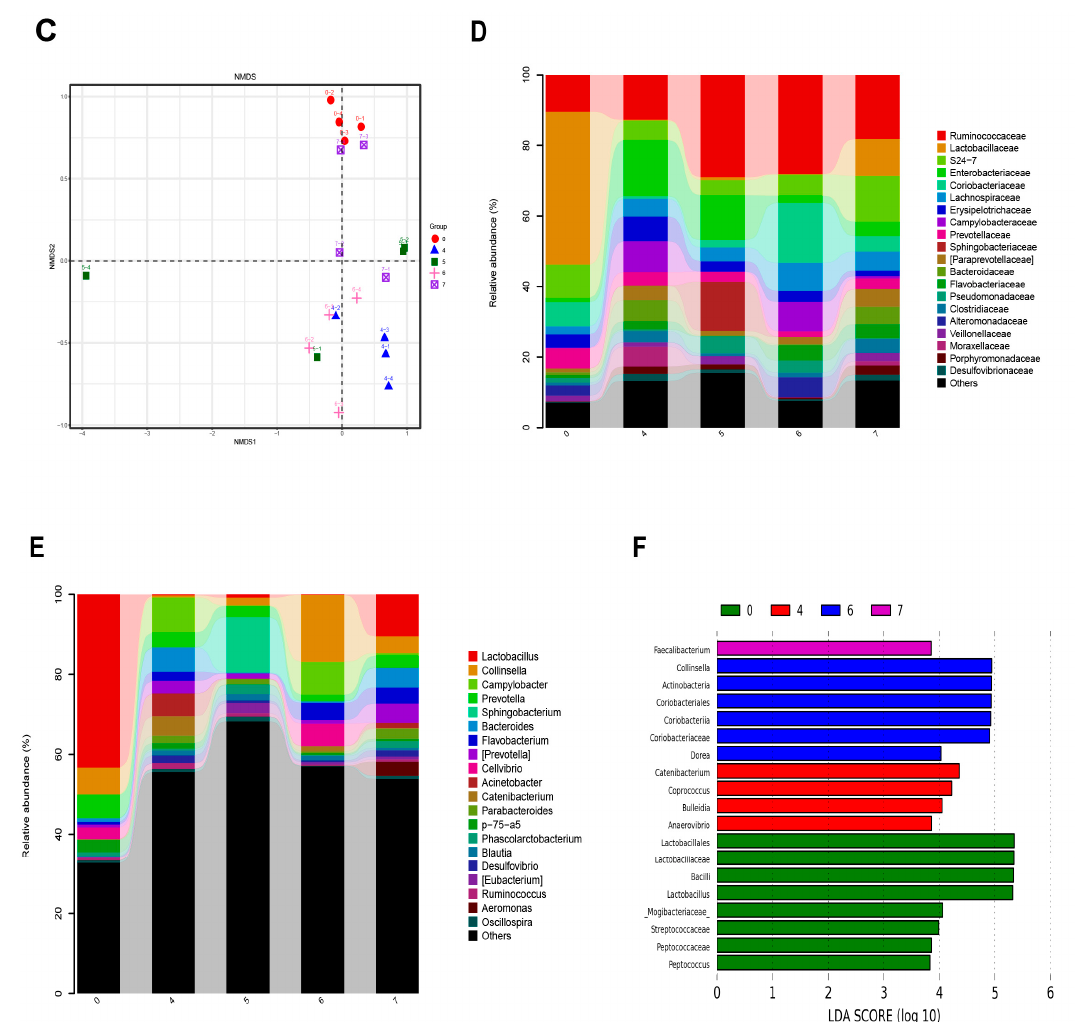
Figure 3. Effects of supplementing the diets with different combinations of SB, MCFAs, and omega − 3 PUFA on microbial counts in the colonic digesta of suckling piglets. ( A ) Venn diagram shows the common and special OTUs distribution among the five groups. ( B ) Alpha diversity of the colonic digesta. ( C ) Nonmetric Multidimensional Scaling analysis (NMDS) on genus level based on UniFrac distances. The relative abundance of colonic microbiota at the phylum level ( D ) and the genus level ( E ). ( F ) The LEfSe analysis screened biomarkers of the microbial community. Data are expressed as the means ± SEM ( n = 4). Note the 0, 4, 5, 6, and 7 groups in the legends indicate the CON, SM, SP, MP, and SMP groups, respectively.